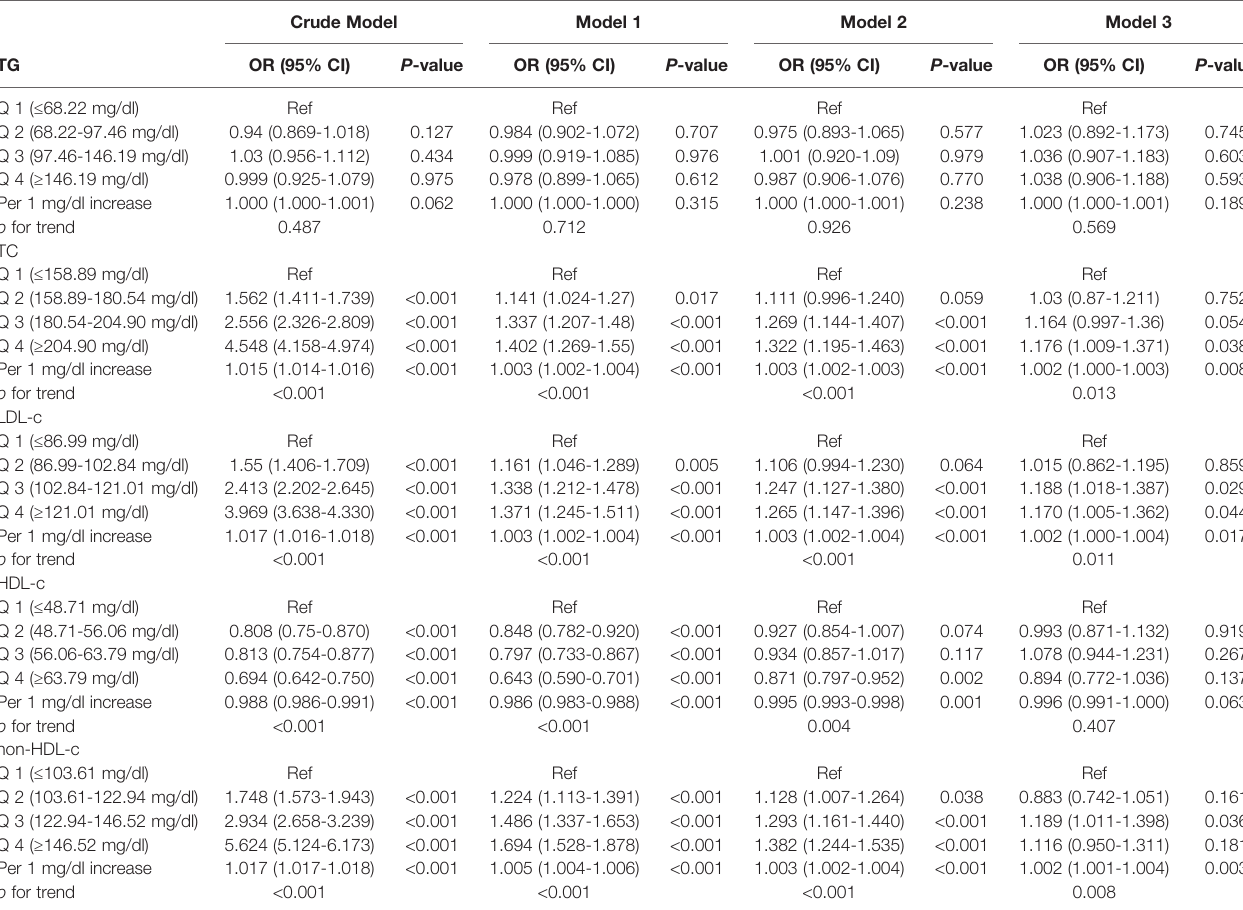
TABLE 3 | Multivariate logistic regression analysis of lipid pro fi le levels and the risk of hypertension.